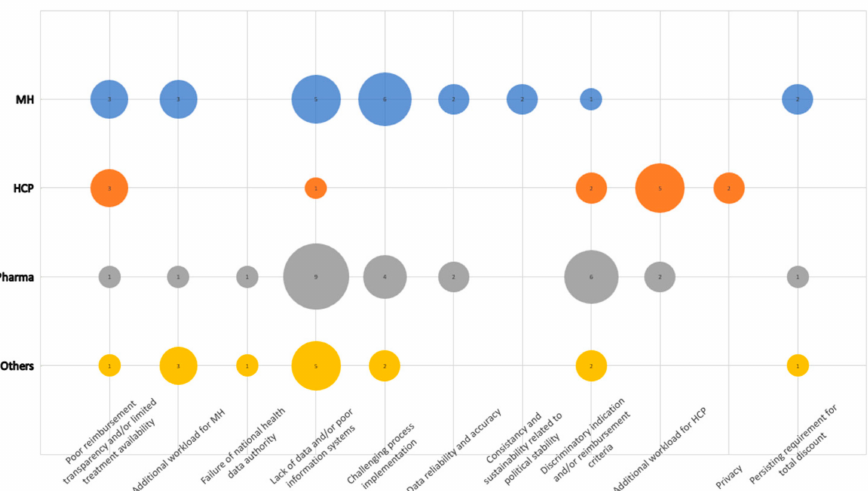
Figure 4. Threats: Frequency chart of codes in the sub-categories within the category threats related to the PB MEA implementation by occupational